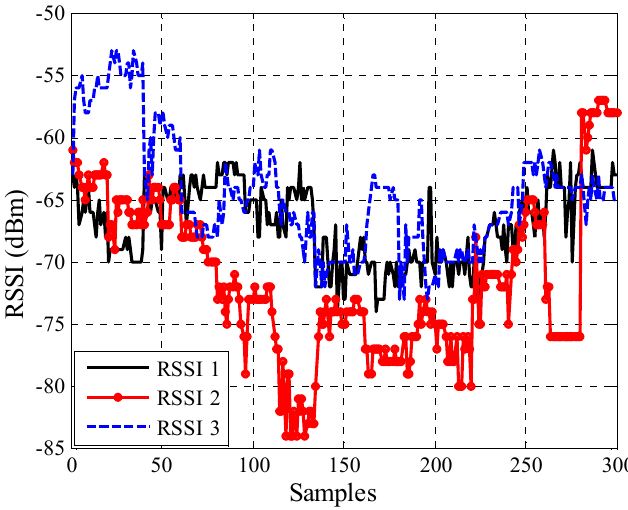
Figure 3. The outdoor experimental setting at the track cycling field (Cheras velodrome).